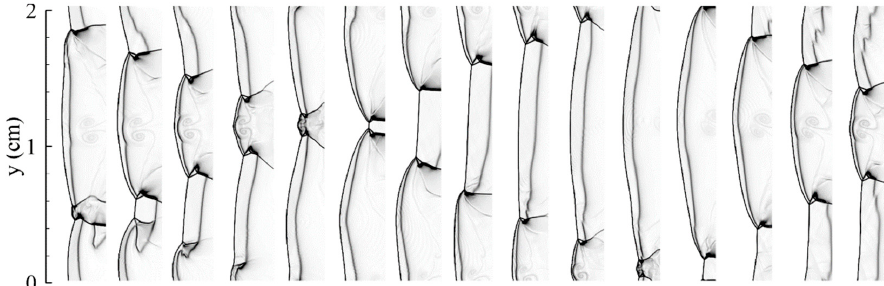
Figure 12. Density gradient of the detonation front from x = − 56.25 to x = − 59.625.